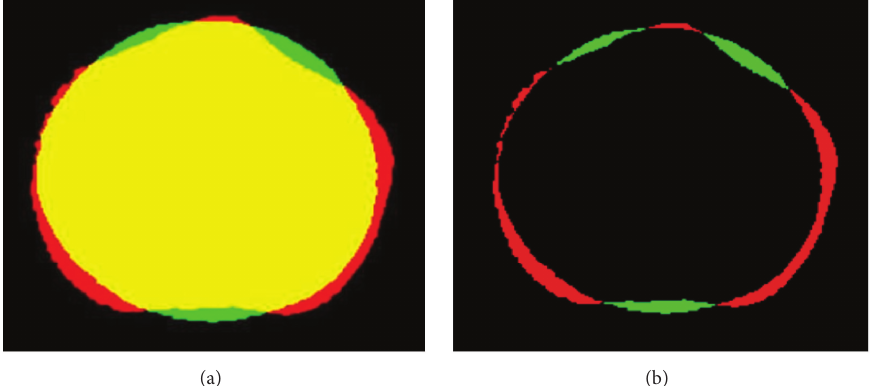
Figure 3: Shape difference between Hands-off and Hands-on. (a) Superimposed slices of two scans; (b) absolute shape difference. Yellow, red, and green regions are the common points, Hands-on, and Hands-off, respectively.